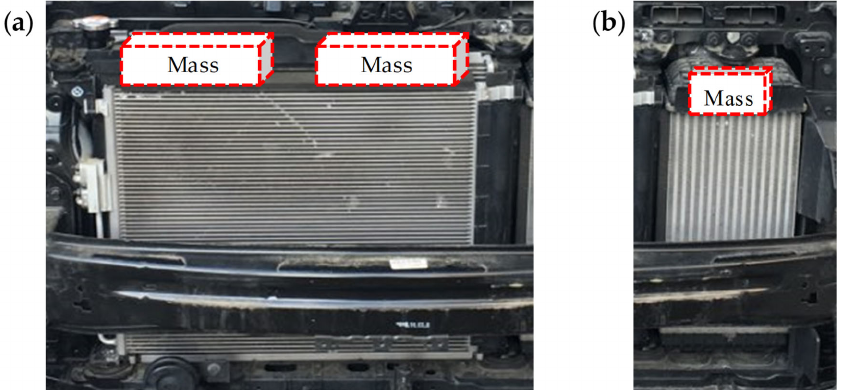
Figure 17. Schematics of added masses to analyze the effect of radiator or intercooler mass on vibration level: ( a ) the radiator and ( b ) the intercooler.